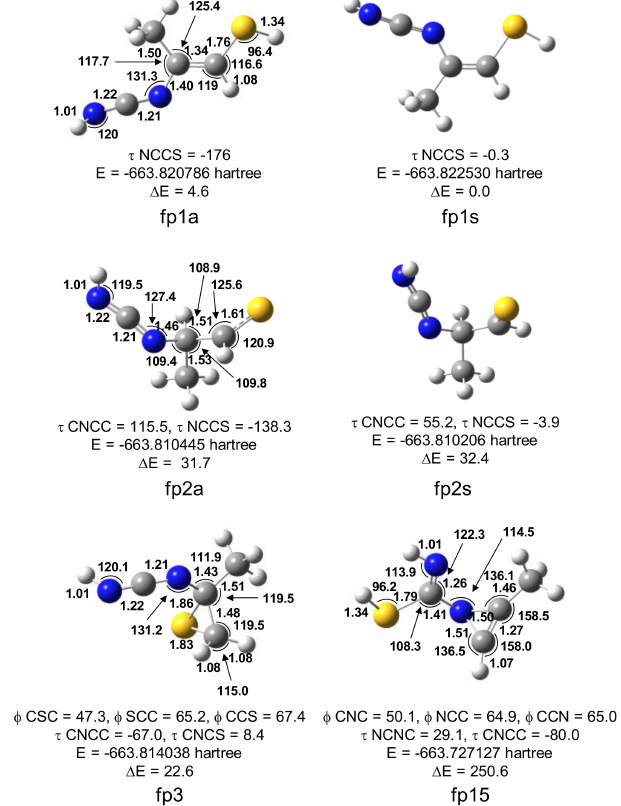
Figure 4. Optimized structures, energies (in hartree) and relative energies ∆ E (in kJ mol − 1 ) of the photoproduct molecules. The numbers in figures represent bond lengths (in Ångstroms) and angles (in degrees). The defined dihedral angles are in